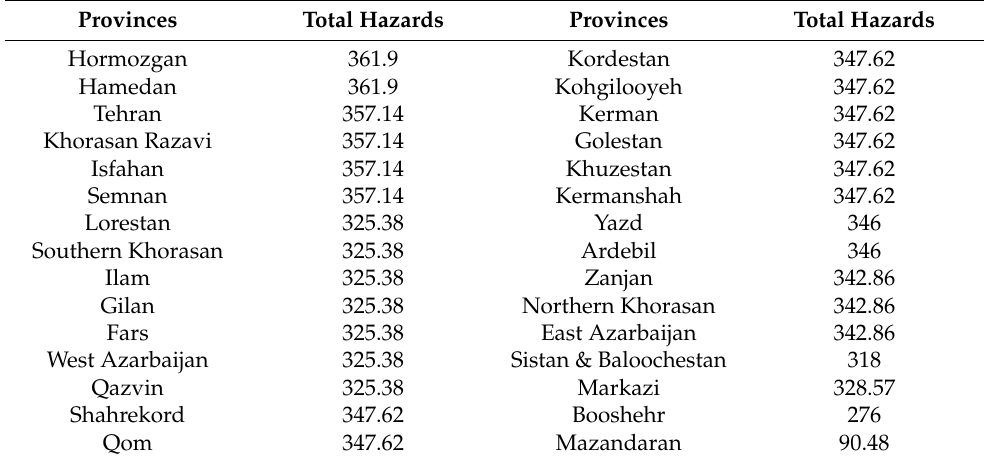
Table 4. Results of hazard calculations in each Iranian